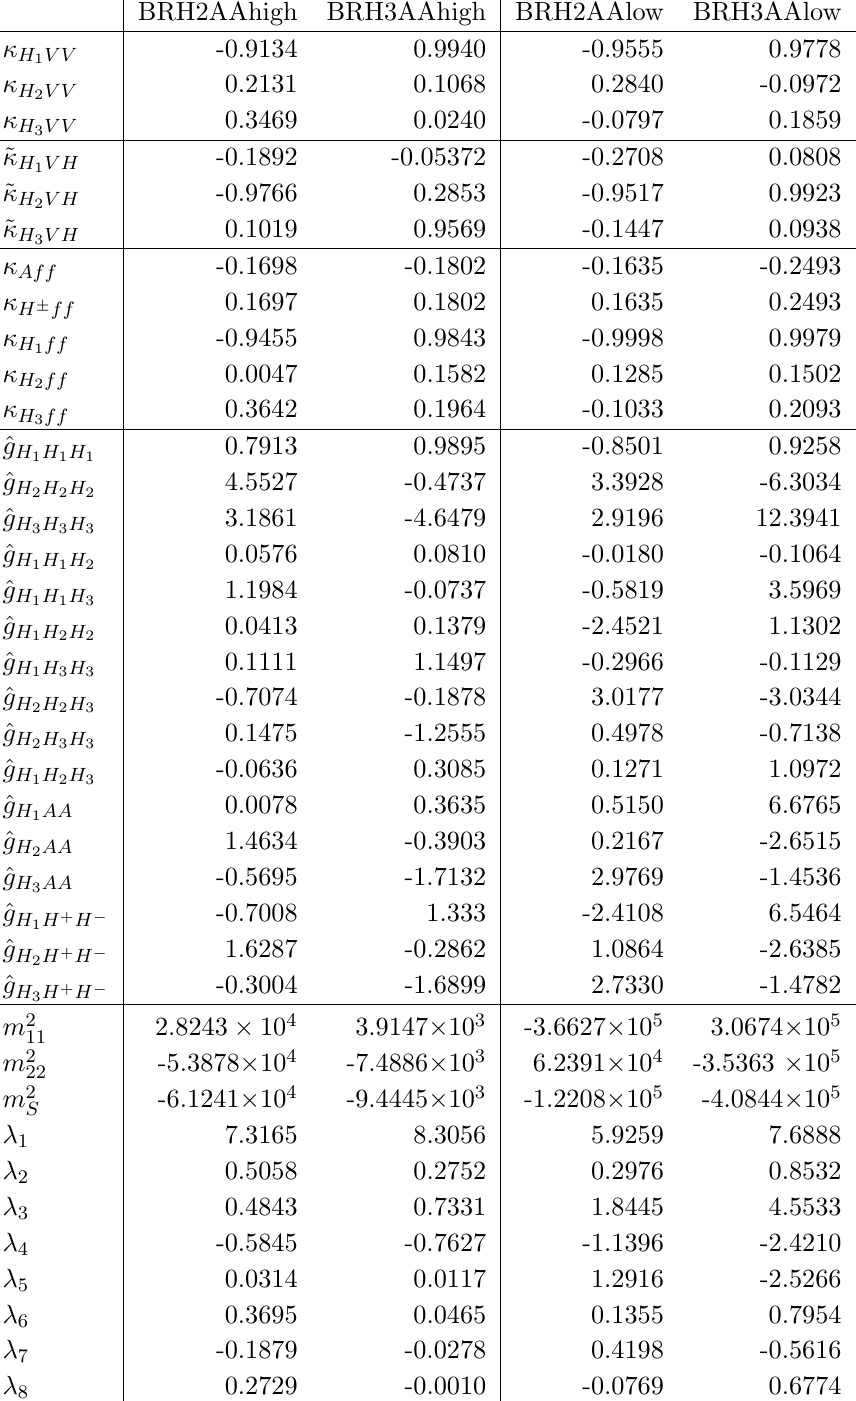
Table 13 . Higgs couplings to gauge bosons, fermions, and an illustrative subset of trilinear self-interactions, for the di(cid:11)erent benchmark scenarios used in the analysis of the decay modes H 2 ; 3 ! AA in section 7. The lowest rows display the values of the mass terms squared (in GeV 2 ) and quartic couplings in the Higgs potential eq. (2.3). The corresponding input parameters are given in table